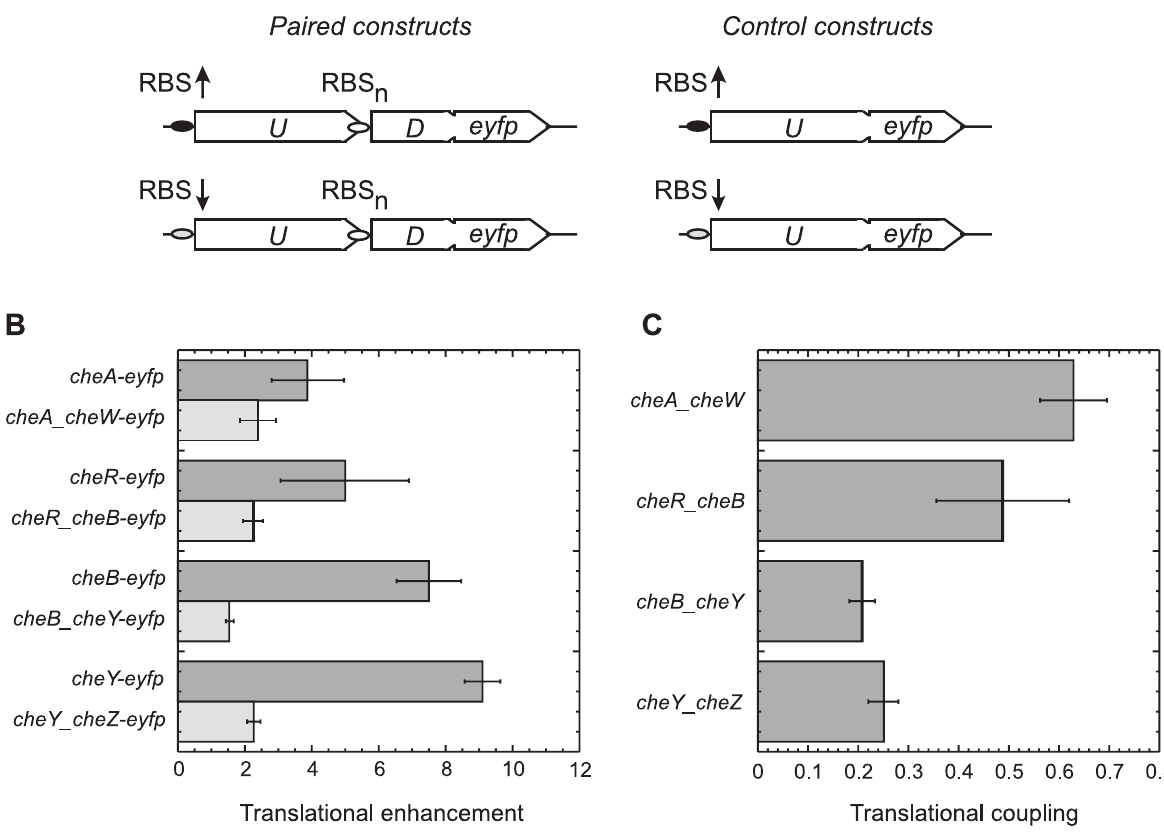
Figure 1. Translational coupling between neighboring genes. (A) Experimental strategy. Bicistronic constructs that contained pairs of neighboring chemotaxis genes in their chromosomal arrangement ( U , upstream gene; D , downstream gene) were cloned under RBSs of different strength as indicated to create a C-terminal YFP fusion ( eyfp , enhanced YFP gene) to a downstream gene. Strong RBS is indicated by a black oval and an up arrow, weak RBS by a grey oval and a down arrow. As a control of the RBS strength, the same sequence was placed in front of the monocistronic YFP fusion to the upstream gene. Downstream gene is under control of its native RBS (RBS n , open oval). Expression of the constructs was analyzed using FACS as described in Materials and Methods. (B) Direct (dark-grey) and indirect (light-grey) up-regulation of expression level of the fusion reporter by the stronger RBS, defined as the ratio of expression of constructs with the strong RBS to expression of corresponding constructs with the weak RBS. For the cheA/cheW pair, translation was regulated by using constructs that express either only short version of CheA or both long and short versions (see text for details). The values of up-regulation at varying (0 to 50 m M) levels of IPTG induction did not differ significantly and were averaged. (C) Translational coupling, defined as the ratio of indirect to direct up-regulation of expression levels by the stronger RBS. Error bars in (B and C) indicate standard deviations.